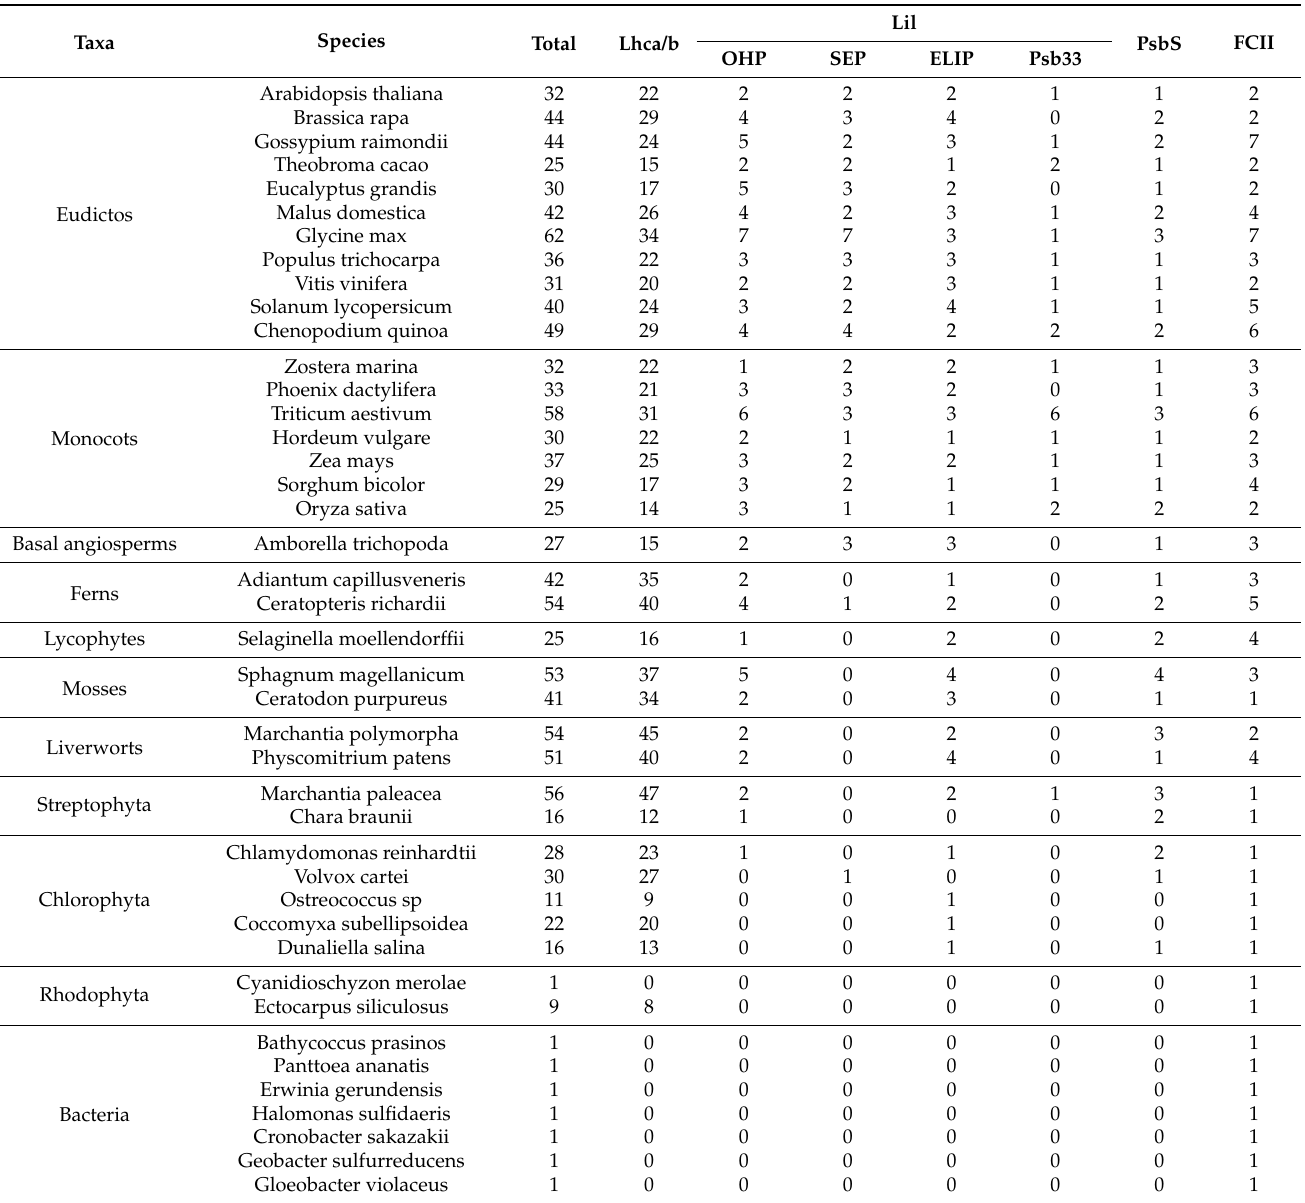
Table 1. Distribution of the members of the LHC gene family in 42 plant